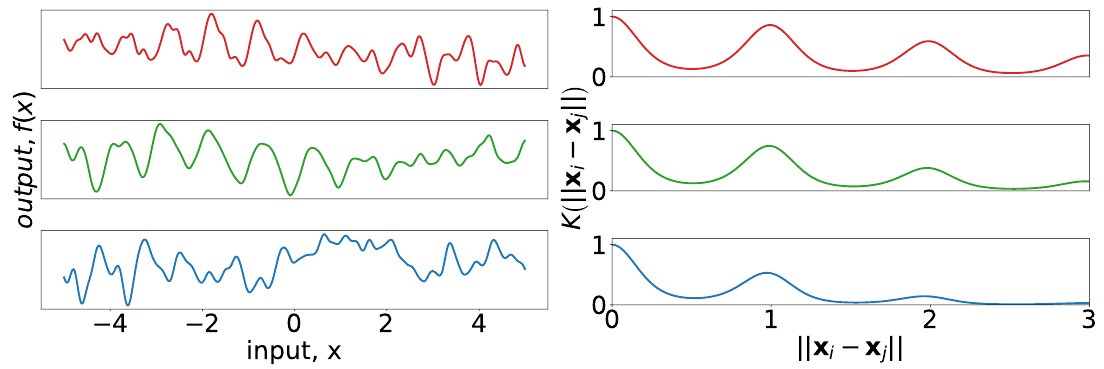
Figure 7. ( left ) Random draws from Gaussian processes with covariances defined by three different decaying periodic kernels. In all cases, the amplitude is 1, the period is 1, and the length-scale of the periodic kernel is 1. The length-scales of the Matérn kernel are 2, 1, 0.5 for top, middle, and bottom, respectively. ( right ) Covariance kernels corresponding to the cases on the